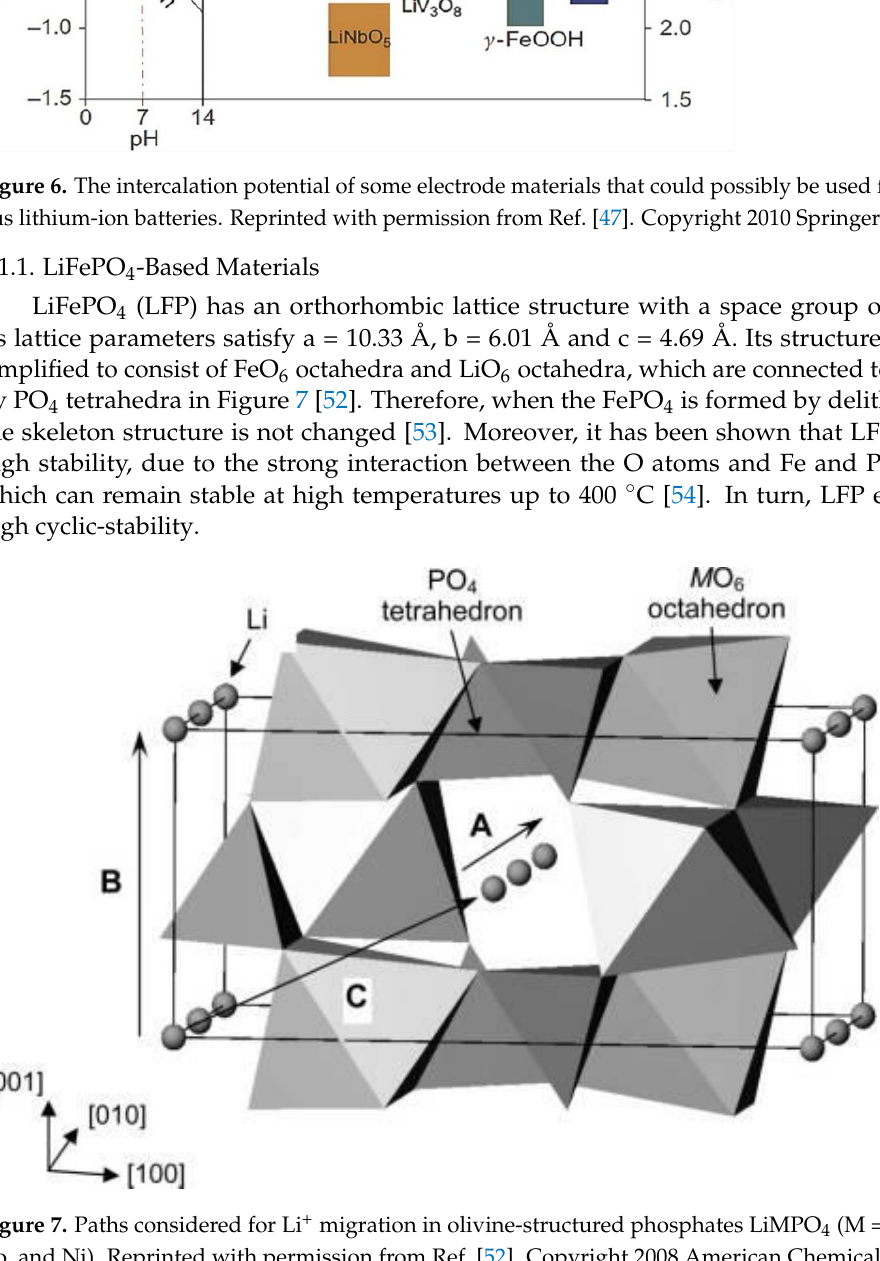
Figure 6. The intercalation potential of some electrode materials that could possibly be used for aqueous lithium-ion batteries. Reprinted with permission from Ref. [47]. Copyright 2010 Springer Nature.